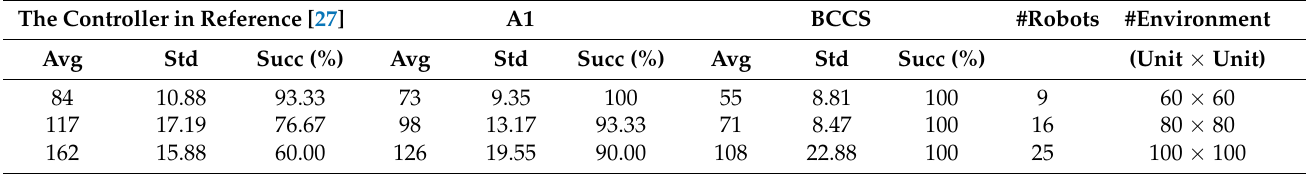
Figure 13. The S evolution of two methods without and with noise for coverage. The red and purple lines are for the controller without and with noise in Reference [27], respectively. The blue and green lines are for A1 without and with noise, respectively. Table 3. Performance comparison results. Avg = average of iterations. Std = standard deviation of iterations. Succ = success